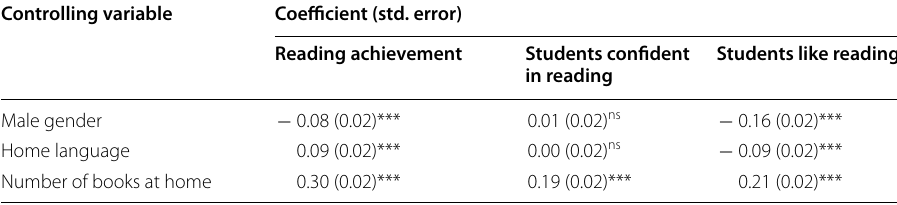
***p < 0.001; **p < 0.01; *p < 0.05; + p < 0.10; ns p